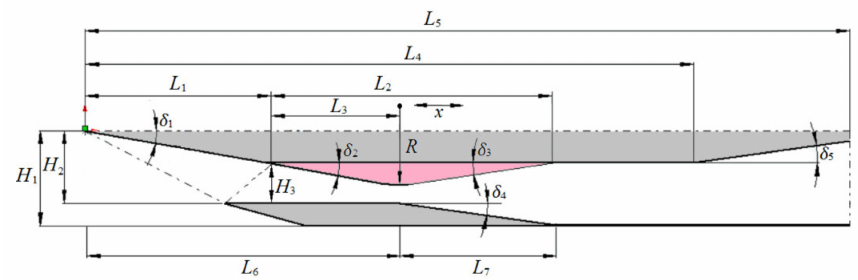
Figure 3. Parameter